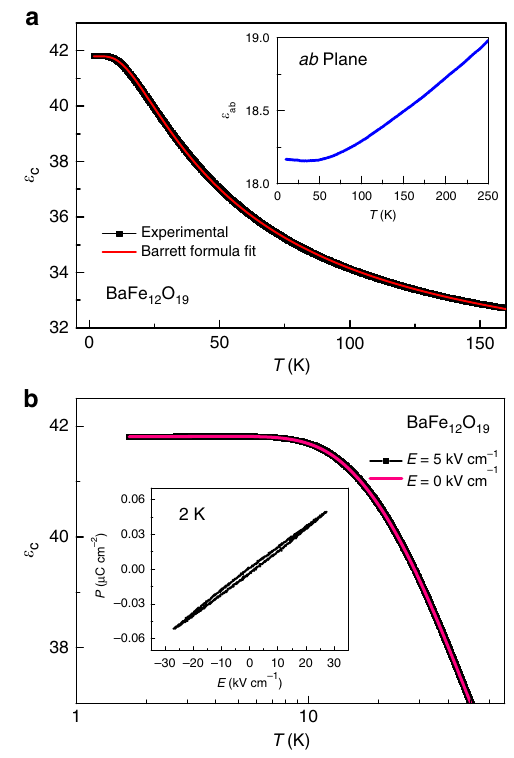
Figure 2 | Dielectric permittivity of BaFe 12 O 19 . ( a ) The temperature dependence of c axis dielectric permittivity e c . The red solid line is the fitting curve to the Barrett formula. The negative fitting parameter T 0 ¼ (cid:2) 22.9(1)K suggests the AFE interaction. The inset shows the dielectric permittivity measured along the [100] direction in the ab plane. d.c. bias electric fields. A bias electric field of 5KVcm (cid:2) 1 has no detectable